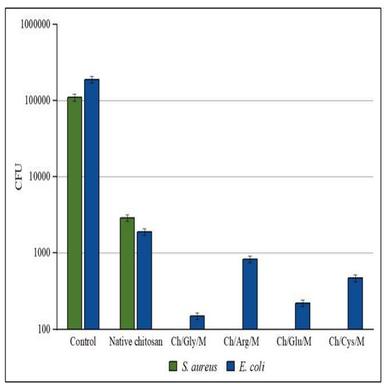
CFU of S. aureus and E. coli observed in Petri dishes after being in contact with native chitosan or its methylated derivatives.